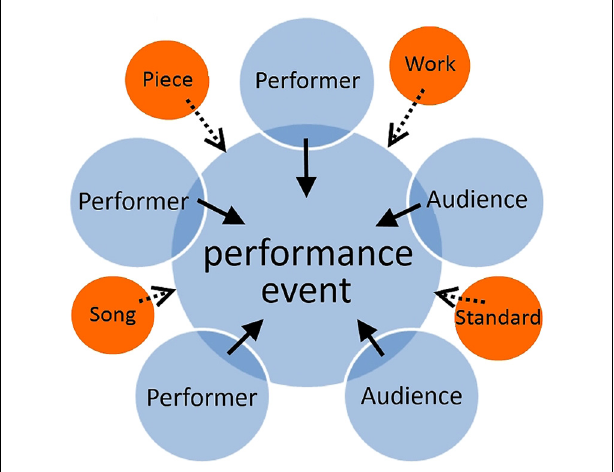
FIGURE 3 | Emergent-Interactional model of musical communication. Performers enact a performance event, which could be founded on a piece, song, standard, or work. Listeners attend to the performance.The perfor- mance is emergent from the actions of all the participants.Where a “work” is being enacted, this exists to serve the